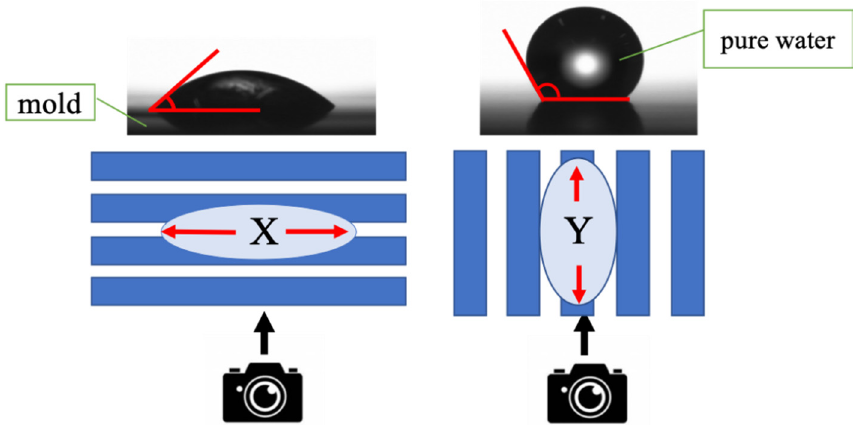
Figure 5. Measurement of the contact angle between 𝑥 and 𝑦 .